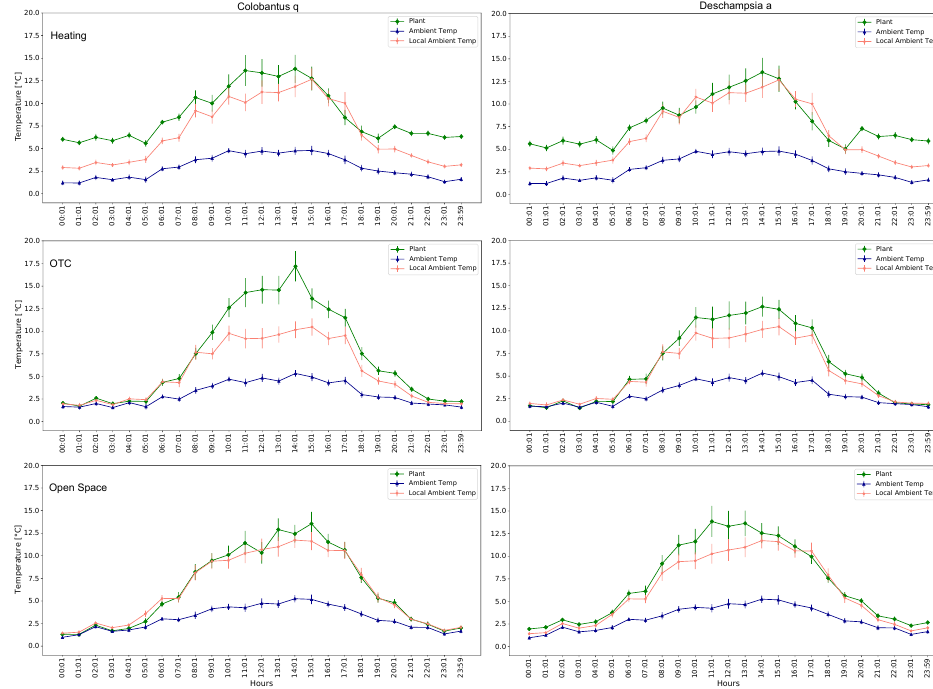
Figure 11. Leaves temperature, air local temperature and reference temperature segmented by plants and groups.